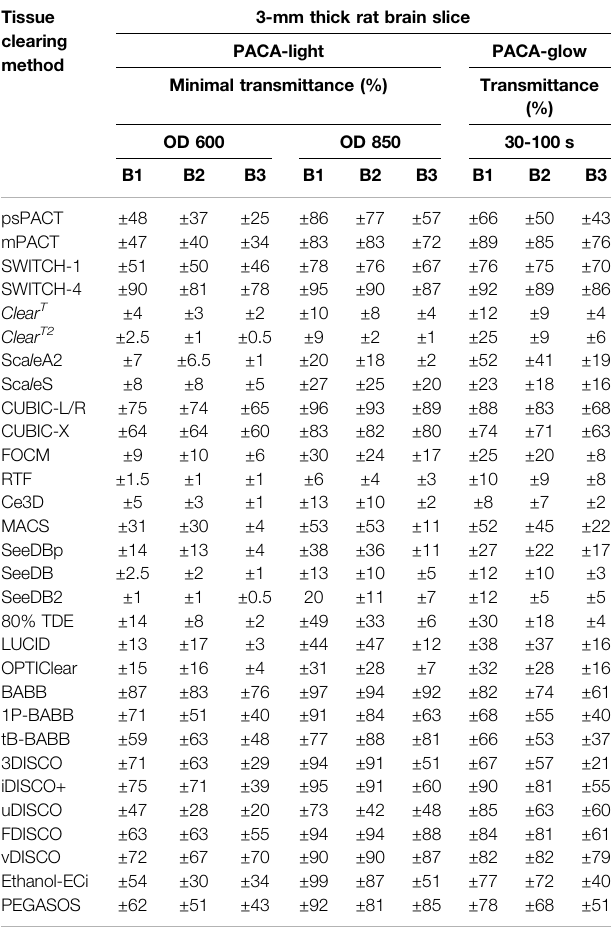
TABLE 1 | Comparison of tissue clearance achieved in rat brains processed via various tissue clearing methods in this study. Tissue